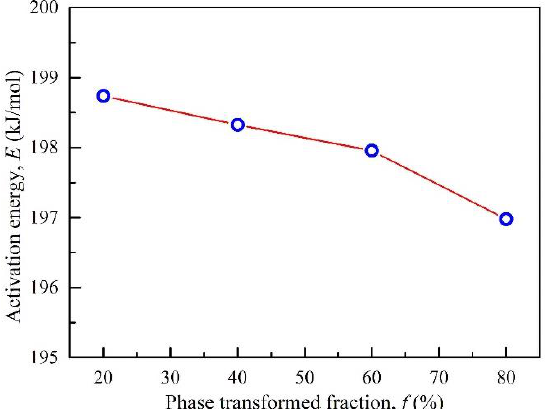
Figure 5. Variation of activation energy at different phase transformed fraction of Al 0.25 CoCrFeNi high-entropy alloy.